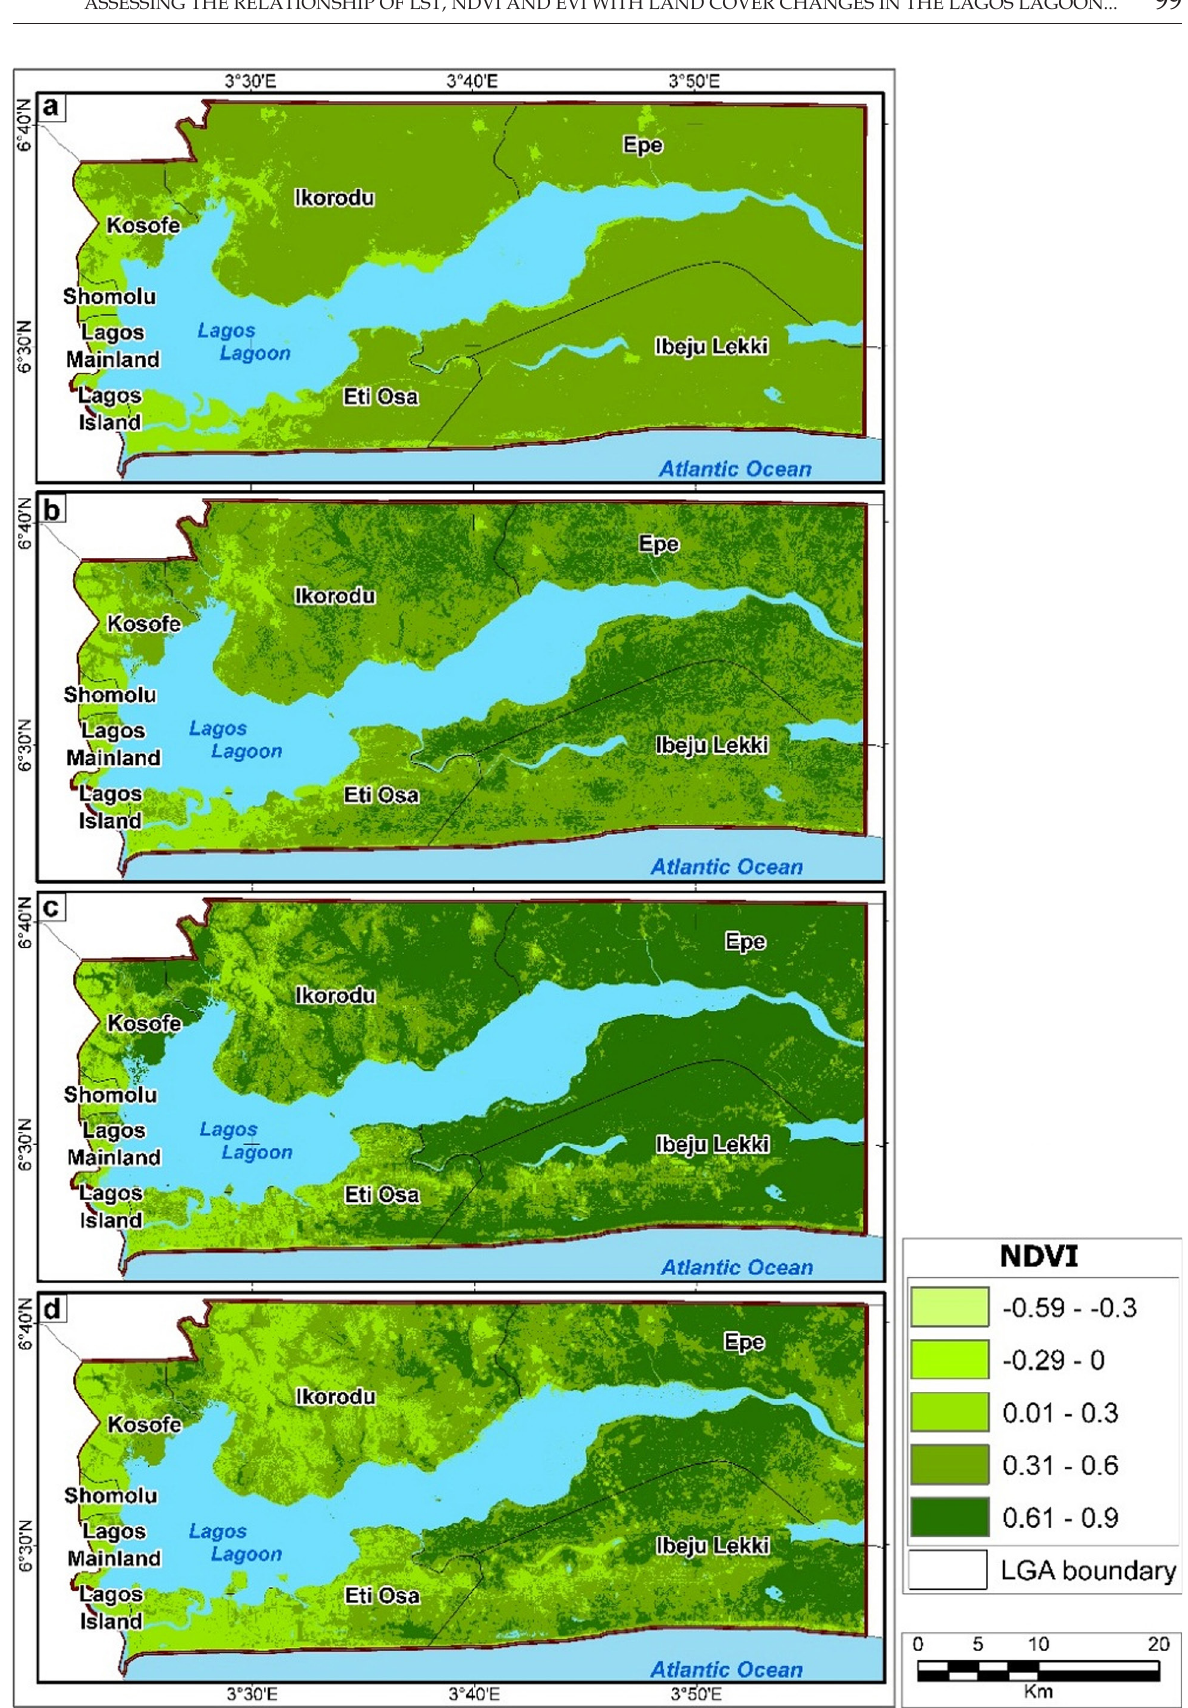
Fig. 6. Spatial pattern of NDVI for 1984 (a), 2002 (b), 2013 (c) and 2019